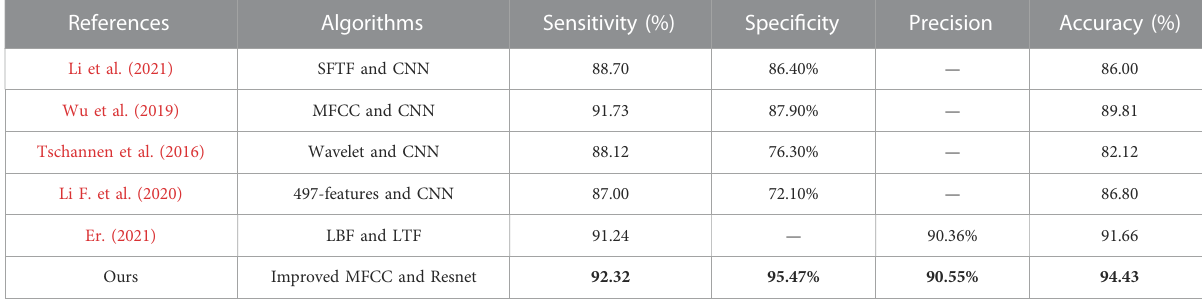
TABLE 5 Comparison of experimental results of different